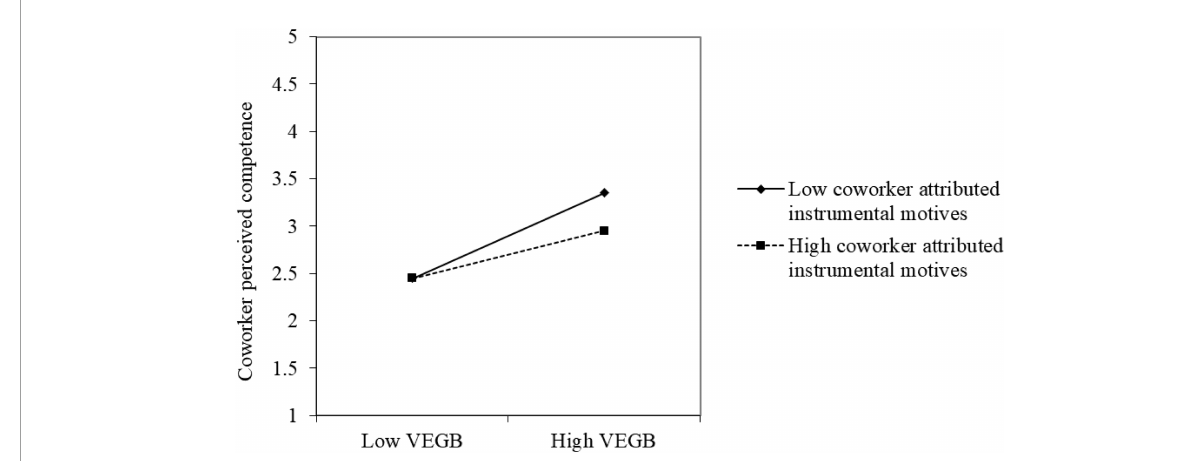
FIGURE4 The interactive effect of VEGB coworker-attributed instrumental motives on perceived competence.